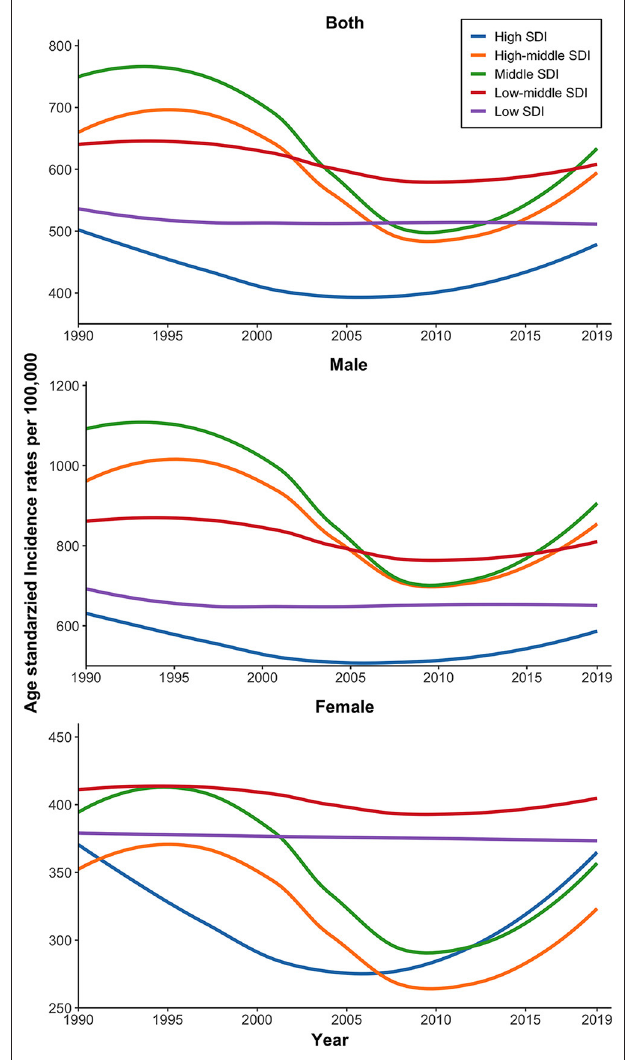
FIGURE 3 | Time trends of the global burden of IOFBs in terms of ASIR (per 100,000 persons) from 1990 to 2019 by SDI and sex. IOFBs, intraocular foreign bodies; ASIR, age-standardized incidence rate; SDI, socio-demographic